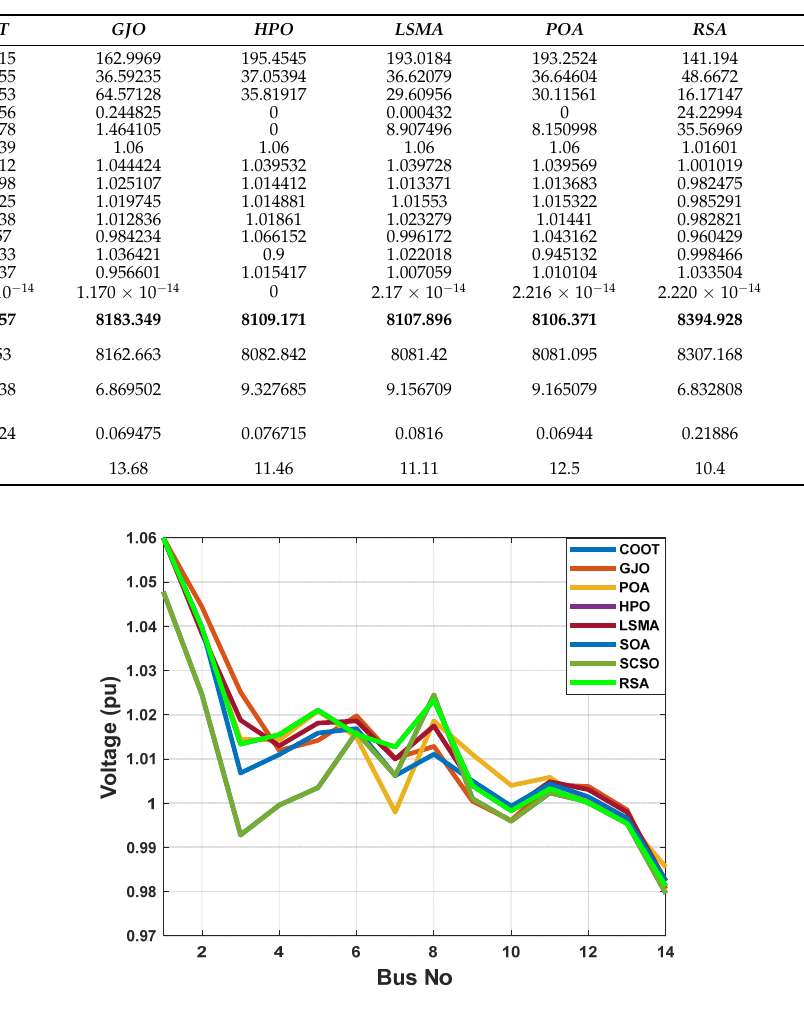
Figure 12. The voltage profile of the POA and other compared algorithms for case 4 in a standard IEEE 14-bus test system.